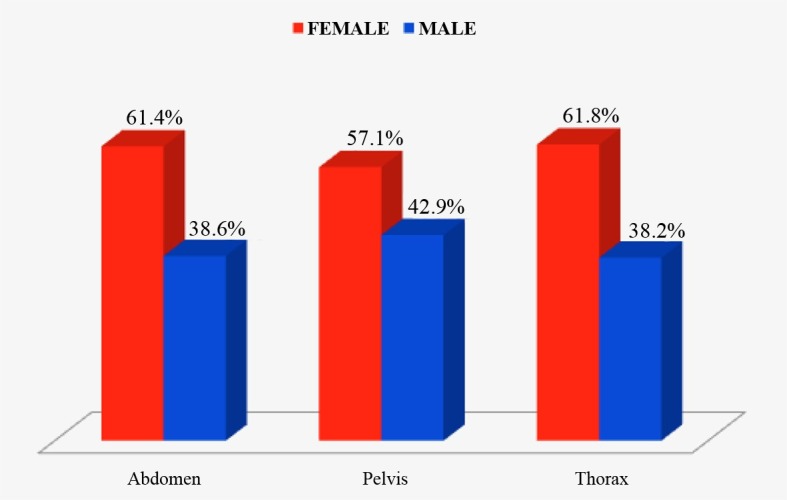
Distribution by topography of CT examination and sex of patients.